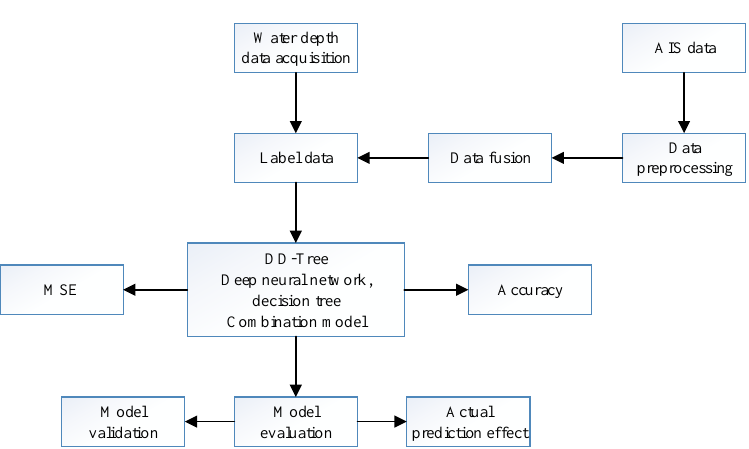
Figure 2. Flow chart of the waterway depth prediction using the proposed DDTree model.